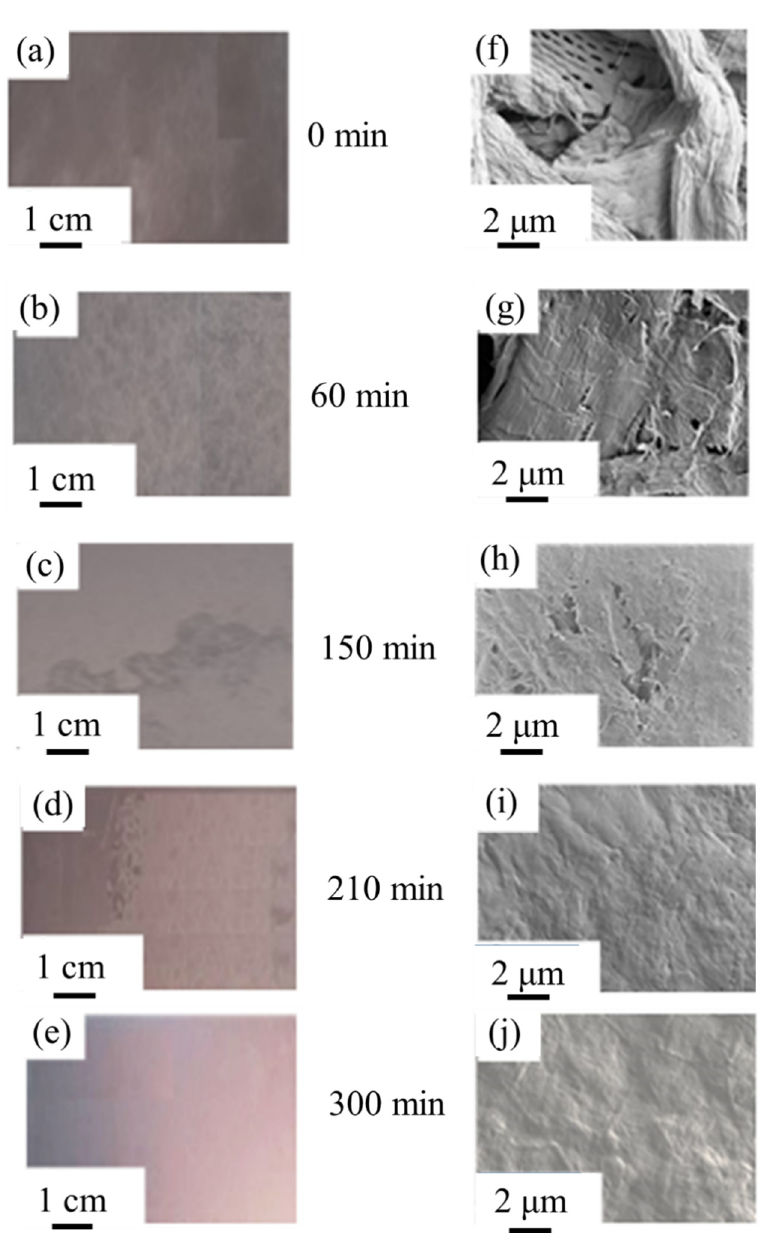
Figure 7. MNFC film images obtained with digital optical camera ( a – e ), and SEM ( f – j ) showing the increase in uniformity as fibres are progressively broken down as a function of enzymatic hydrolysis pretreatment over time.